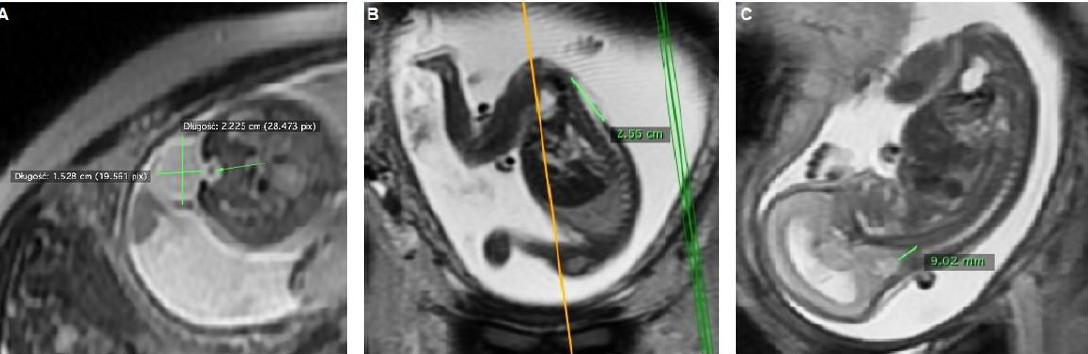
Figure 2. Assessment of Chiari II malformation on fetal MRI at 24.2 weeks of gestation: ( A ) Transverse view: end of the medullary cone at L 5 , MMC measurements; ( B ) Longitudinal view, MMC length, upper level of the defect: L 2 ; ( C ) Sagittal view: HBH stage II (Sutton Scale).